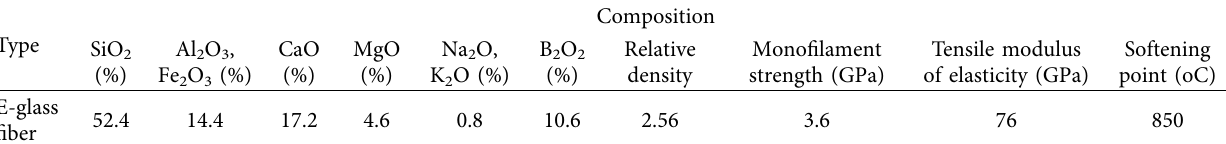
Figure 2: Glass fiber material to be used. Table 2: Composition and basic properties of E-glass